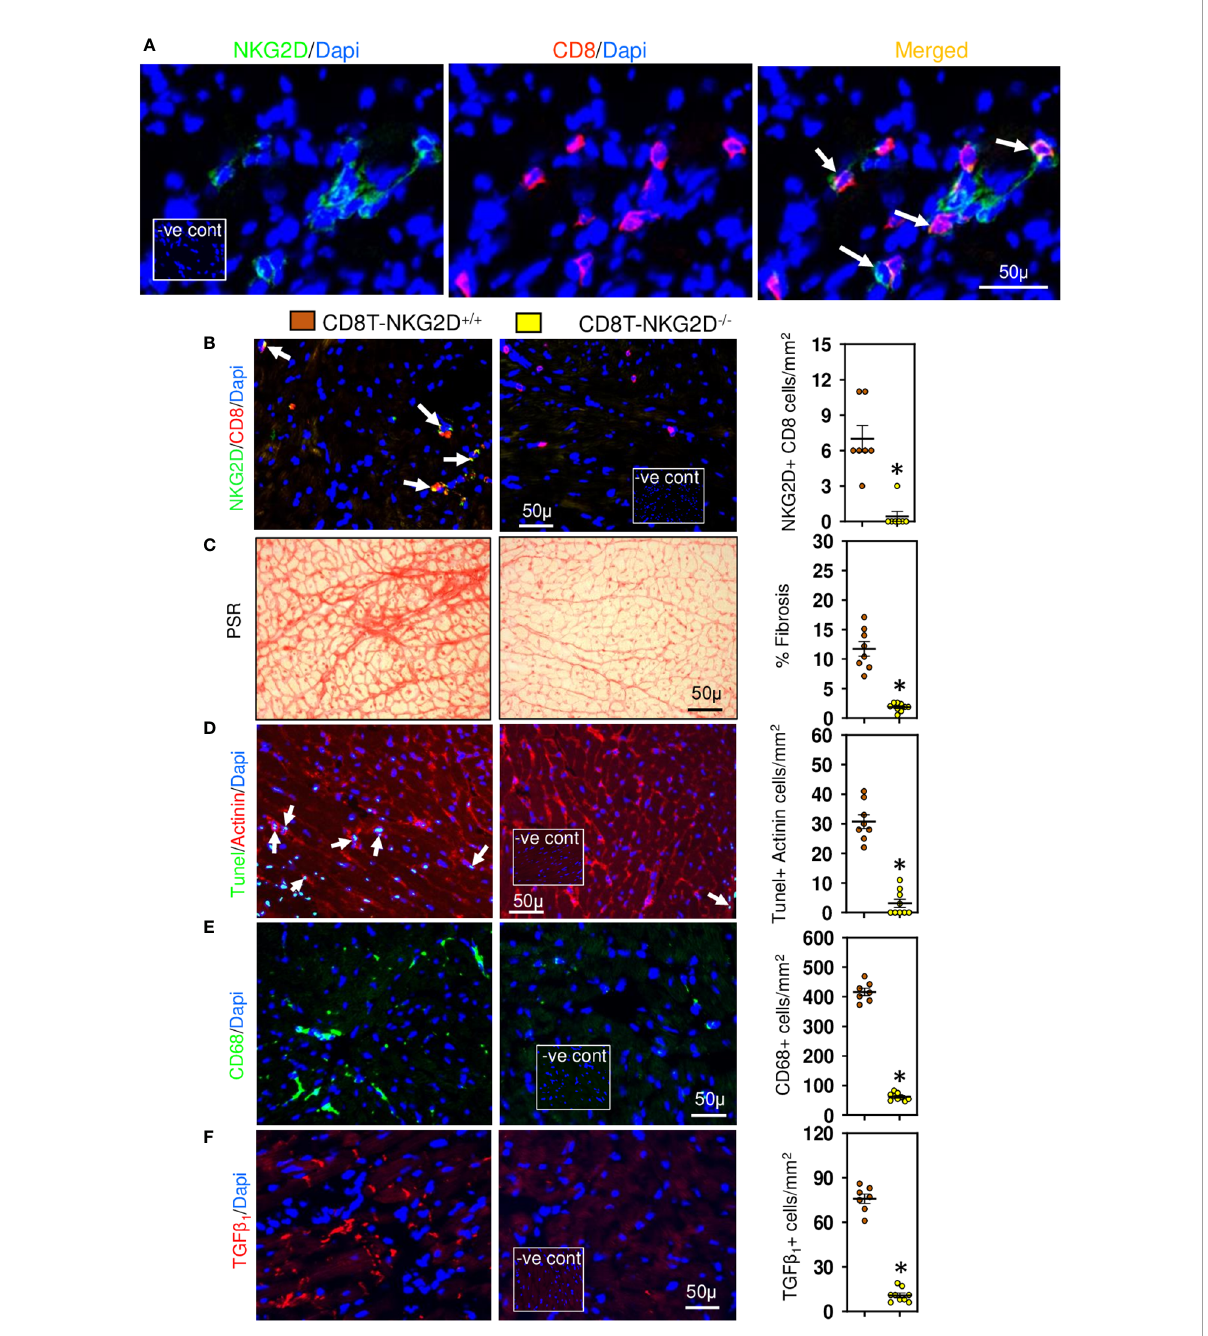
FIGURE 4 Cardiac CD8+ T cells require NKG2D receptors to promote fi brosis. (A) Photomicrographs indicating that CD8+ cells accumulated in LV of TAC mice express NKG2D receptor. (B) CD8+ T cells of TAC mice that underwent bone marrow transplantation with mixed bone marrow de fi cient in NKG2D (CD8T-NKG2D -/- ) do not express NKG2D compared to controls (CD8T-NKG2D +/+ ). (C) LV fi brosis is attenuated in TAC mice with NKG2D-de fi cient CD8+ T cells. (D) TUNEL+ Actinin+ cardiomyocytes are greatly reduced in mice with NKG2D-de fi cient CD8+ T cells. (E, F) LV CD68+ macrophages and TGF- b 1 expressing cells in TAC mice with NKG2D-de fi cient CD8+ T cells are markedly reduced. Results are means ± SEM with small circles representing data from individual mice. n=7-9/group. PSR; picrosirius, -ve control; no primary antibody control, scale bar represents 50µm. *P< 0.05 using two tailed Student ’ s t-test comparing to CD8T-NKG2D +/+